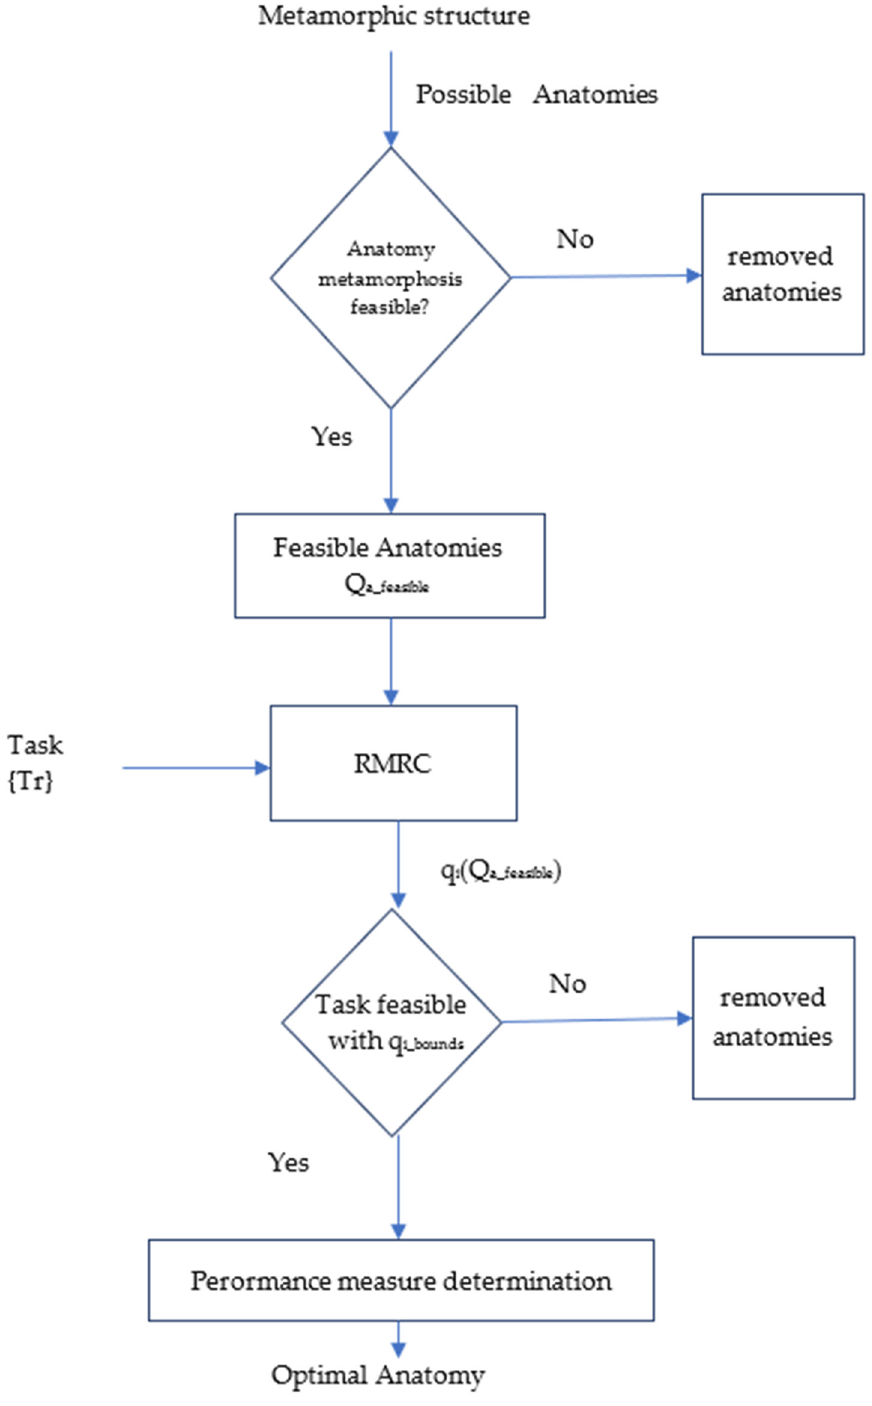
Figure 2. Flowchart of the proposed methodology.